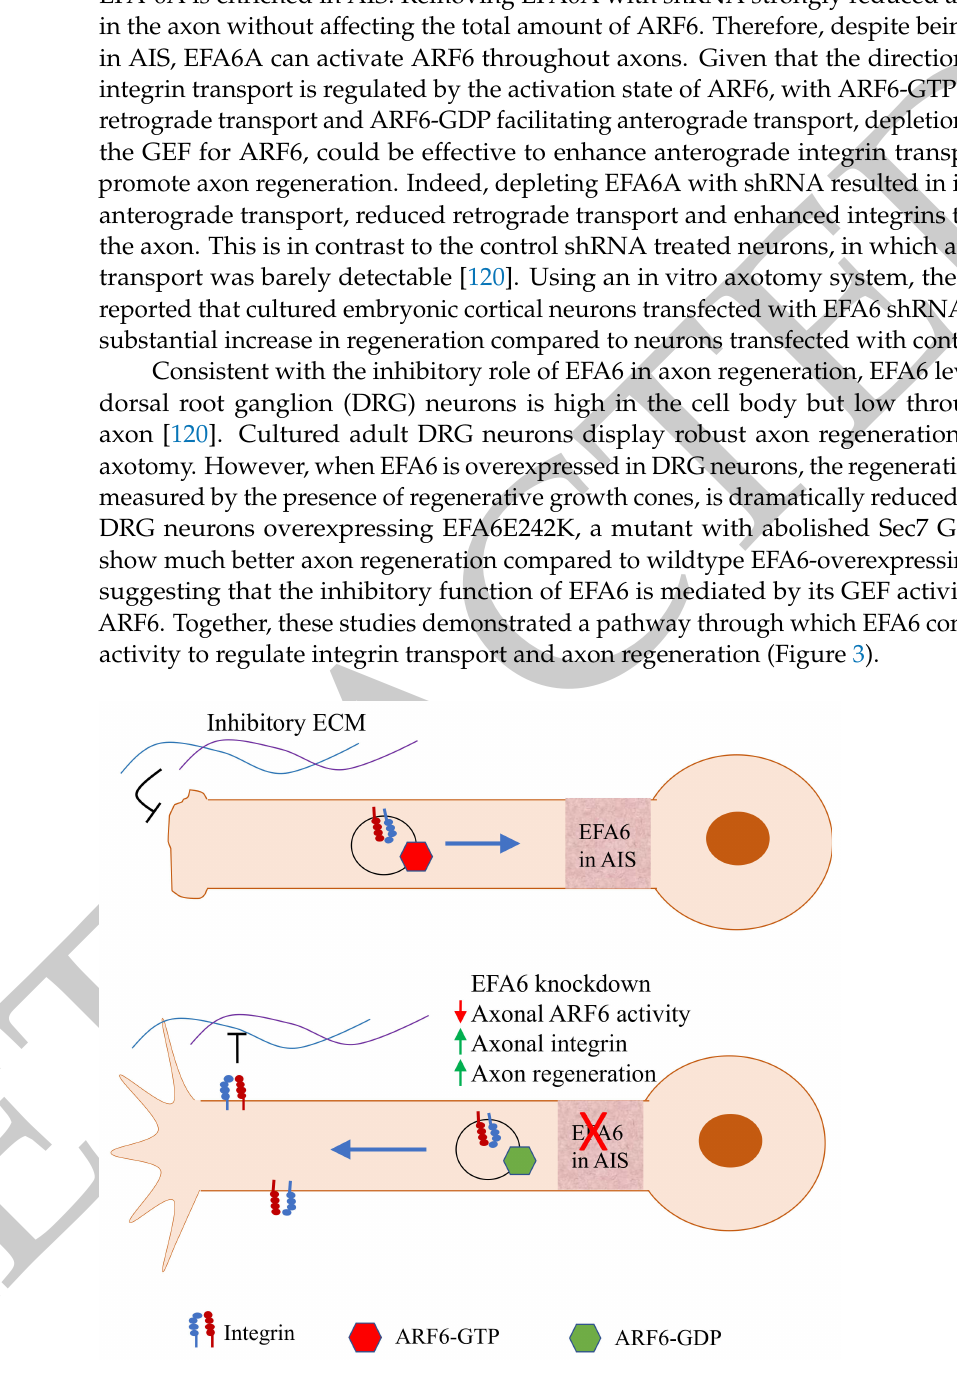
Figure 3. EFA6 inhibits axon regeneration by activating ARF6 to regulate integrin transport.